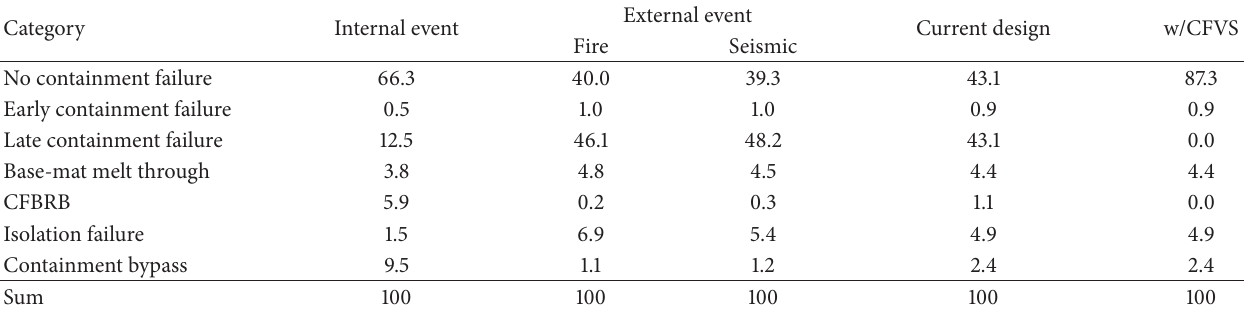
Table 7: Overall safety improvement effect by the installation of the